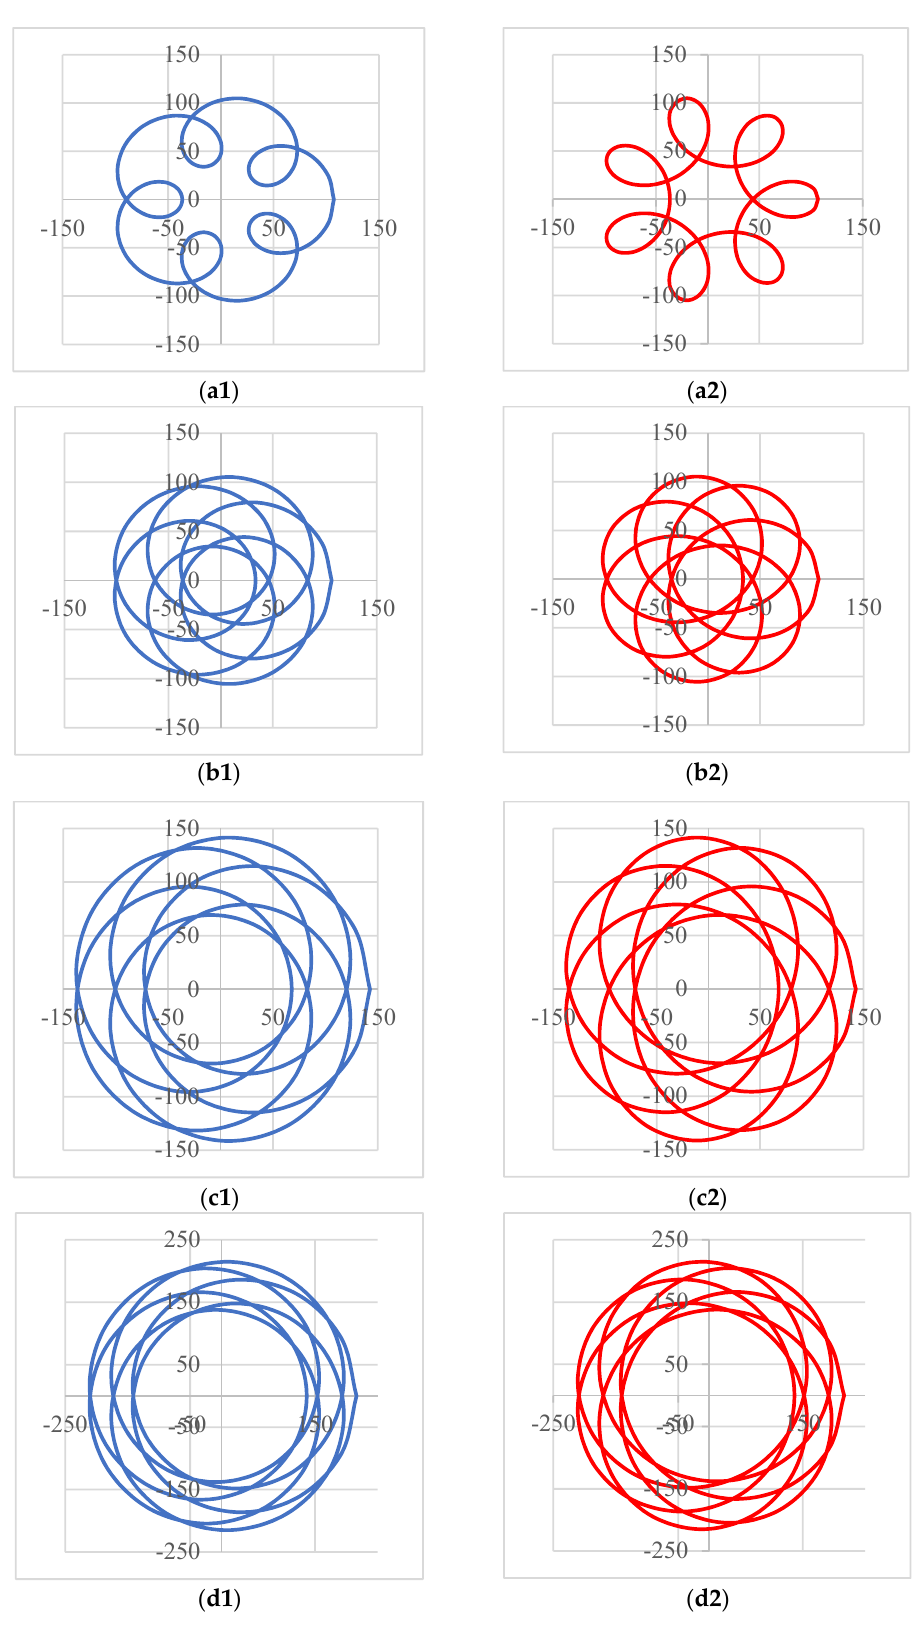
Figure 4. Study of the scan patterns produced by a pair of rotational Risley prisms (i.e., the configuration ba-ab in Figure 2d) for L = 1 m, e = 25 mm and for: ( a ) | M | = 2; ( b ) | M | = 4; ( c ) | M | = 6; ( d ) | M | = 8. ( 1 ) Left column, M > 0; ( 2 ) right column, M < 0 . The k = 1 case was considered for identical prisms with an individual deviation angle D = ( n − 1) θ = 2°. The values on the axes are in millimeters.